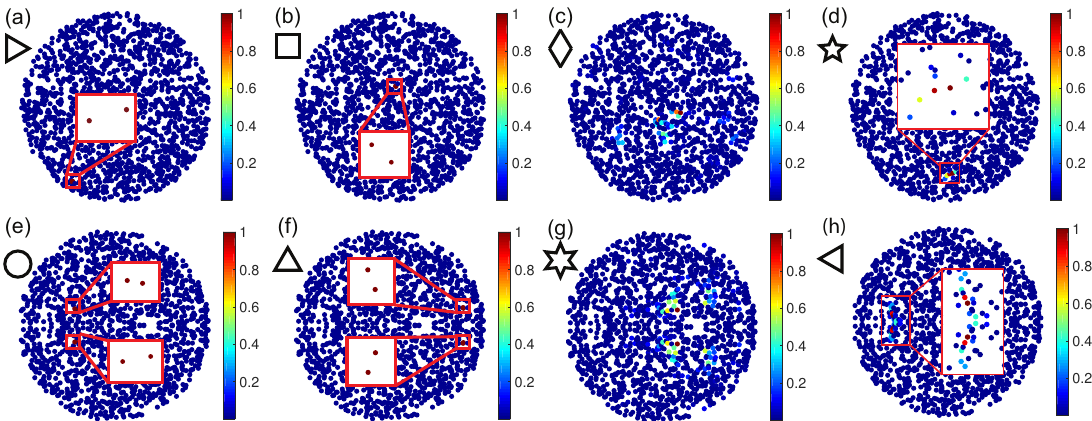
Figure 4. Representative spatial distributions of the Green’s matrix eigenvectors that belong to the class of scattering resonances identified in the complex plane of Figure 3b,d. Specifically, panels ( a – d ) and panels ( e – h ) refer to the UR and EC configurations,